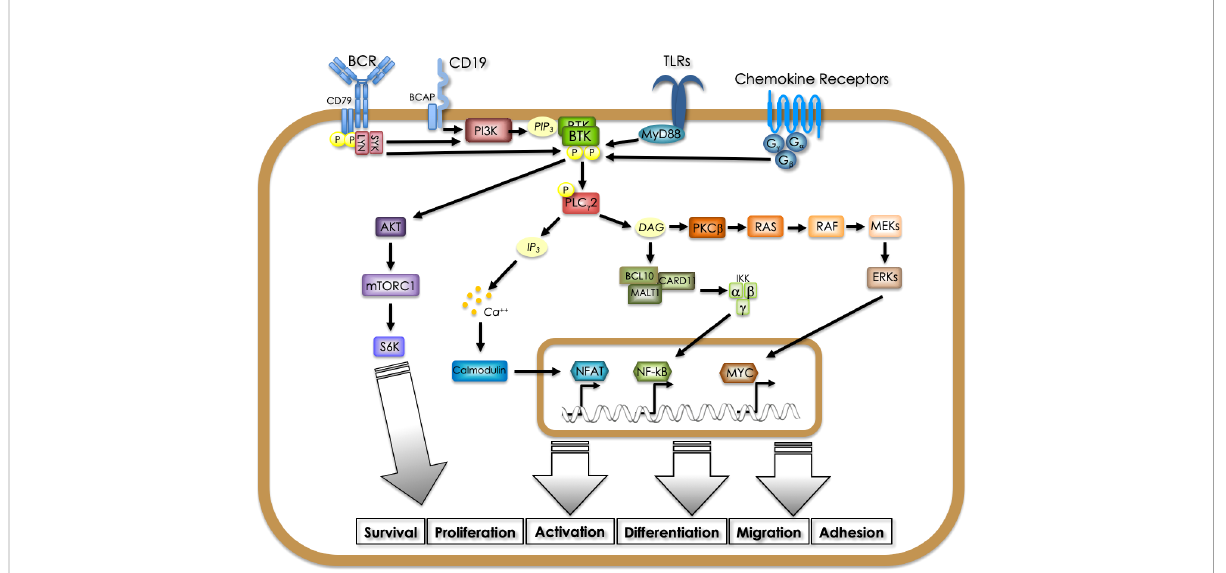
FIGURE 1 Signaling pathways involving BTK in B cells. BTK is activated downstream of different receptors (BCR, CD19, BAFFR, TLRs, chemokine receptors), being pivotal for relaying activation, proliferation, differentiation, survival, migration and adhesion signals. Different adaptors and kinases convey on BTK activation depending on the stimulated receptor. PI3K-generated PIP3 binding to the N-terminal PH domain allows membrane recruitment and phosphorylation-mediated activation. BTK-mediated phosphorylation activates PLC g 2 leading to IP3 and DAG generation which ultimately trigger NFAT-dependent transcription and RAS-MAPK and NF-kB pathway activation, respectively. In addition, BTK can activate directly the AKT-mTOR